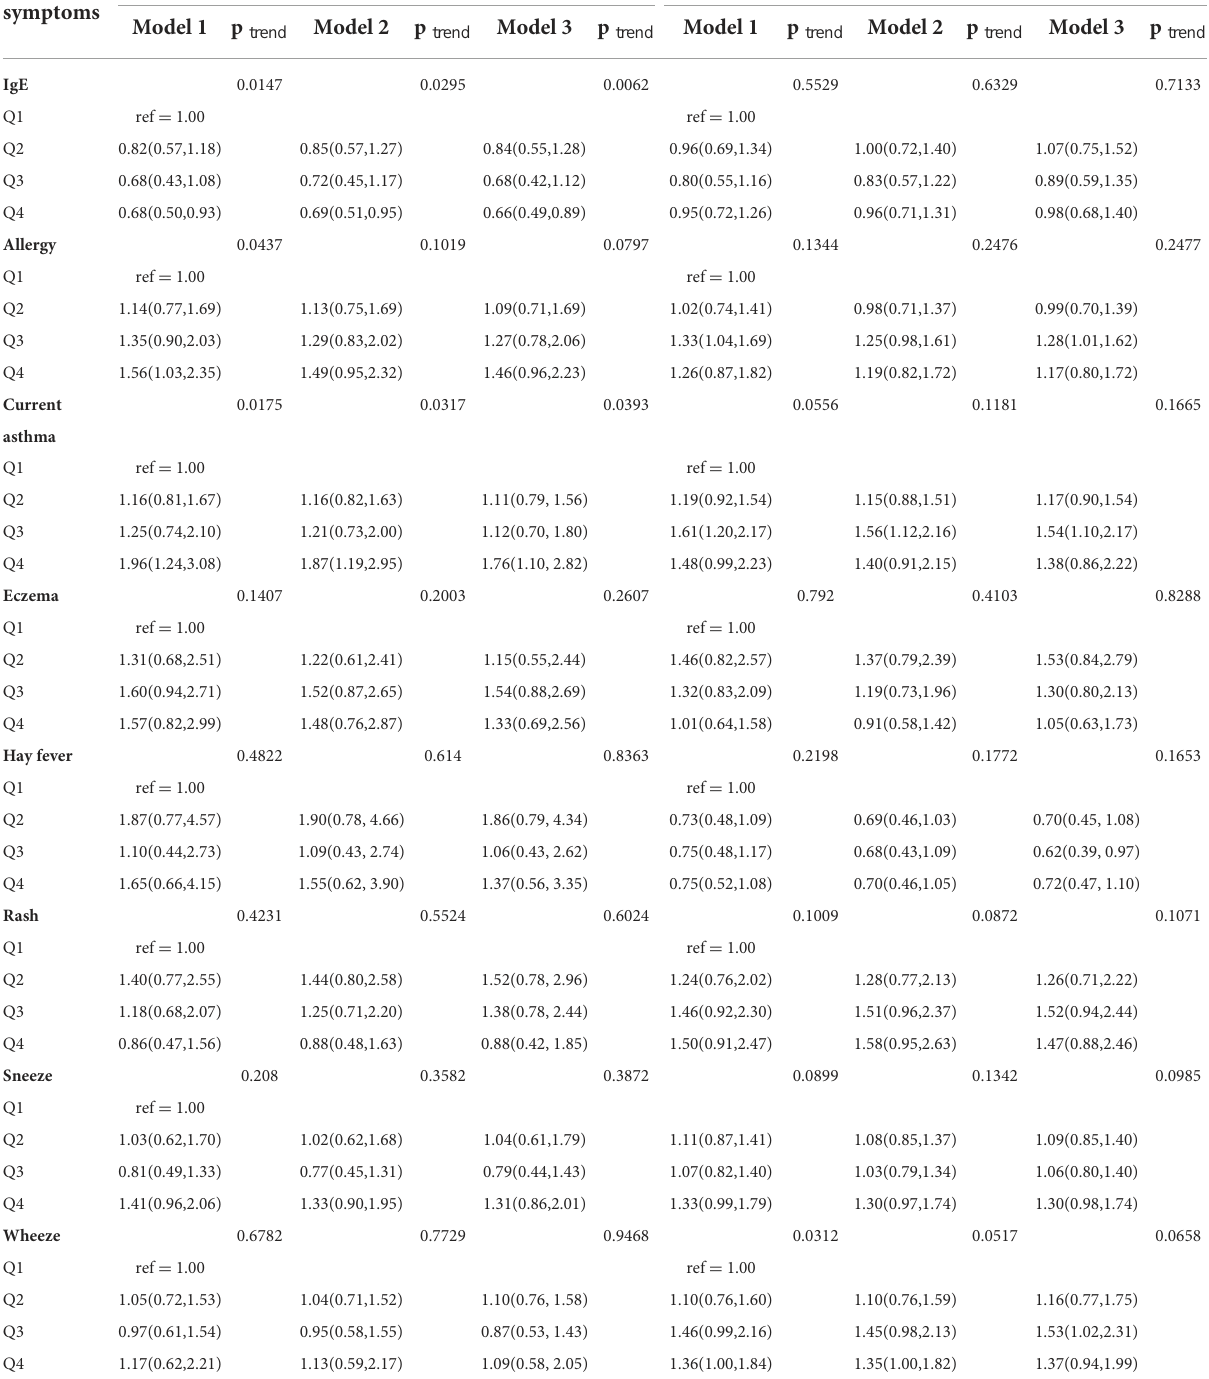
TABLE 2 Odds ratios of the associations between UPFs and allergic symptoms in children and adults, NHANES